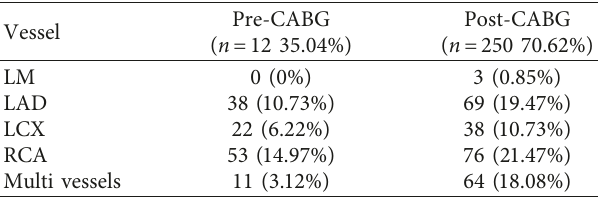
Table 3: Characteristics of lesion distribution. Preoperative and postoperative analyses of CTO